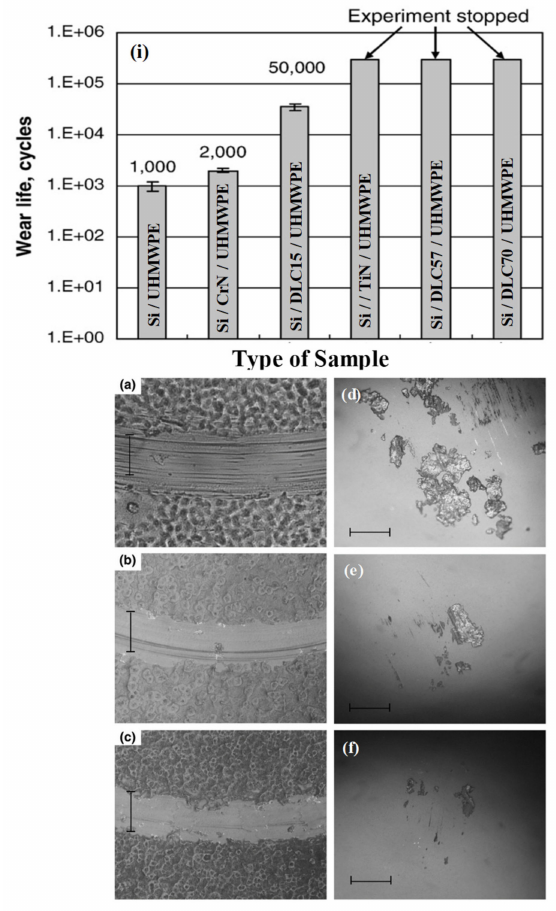
Figure 5. ( i ) Wear life of Si coated with different composite films. [( a – c )]–Optical images of the wear tracks and [( d – f )]–Optical images of the counterface Si 3 N 4 balls after a wear test for 300,000 cycles on UHMWPE coatings deposited on TiN, DLC57 and DLC70 layers, respectively [55]. The applied load was 40 mN and the rotational speed was 500 rpm (linear speed = 0.052 m/s). Reproduced with permission from Myo Minn, Sujeet K Sinha, Thin Solid Films; published by Elsevier,